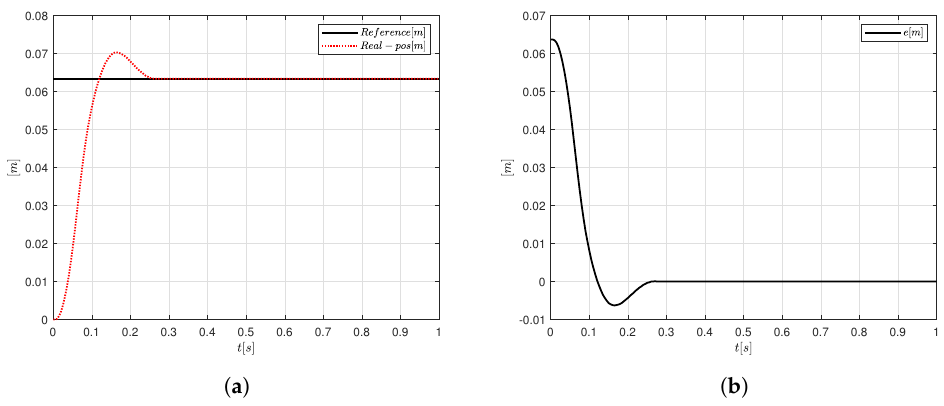
Figure 9. PID-like FLC response using a step signal ( a ) position and ( b )